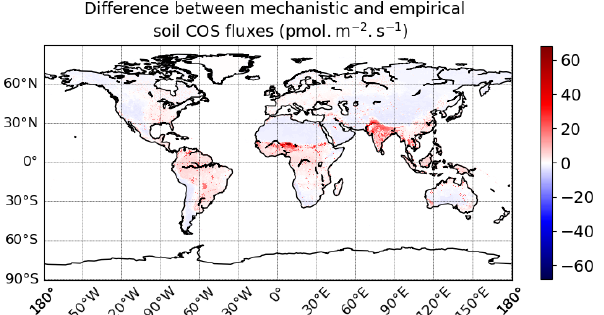
Figure D1. Mean difference between soil COS fluxes computed with the mechanistic and the empirical model over 2010–2019. The map resolution is 0.5 ◦ × 0.5 ◦